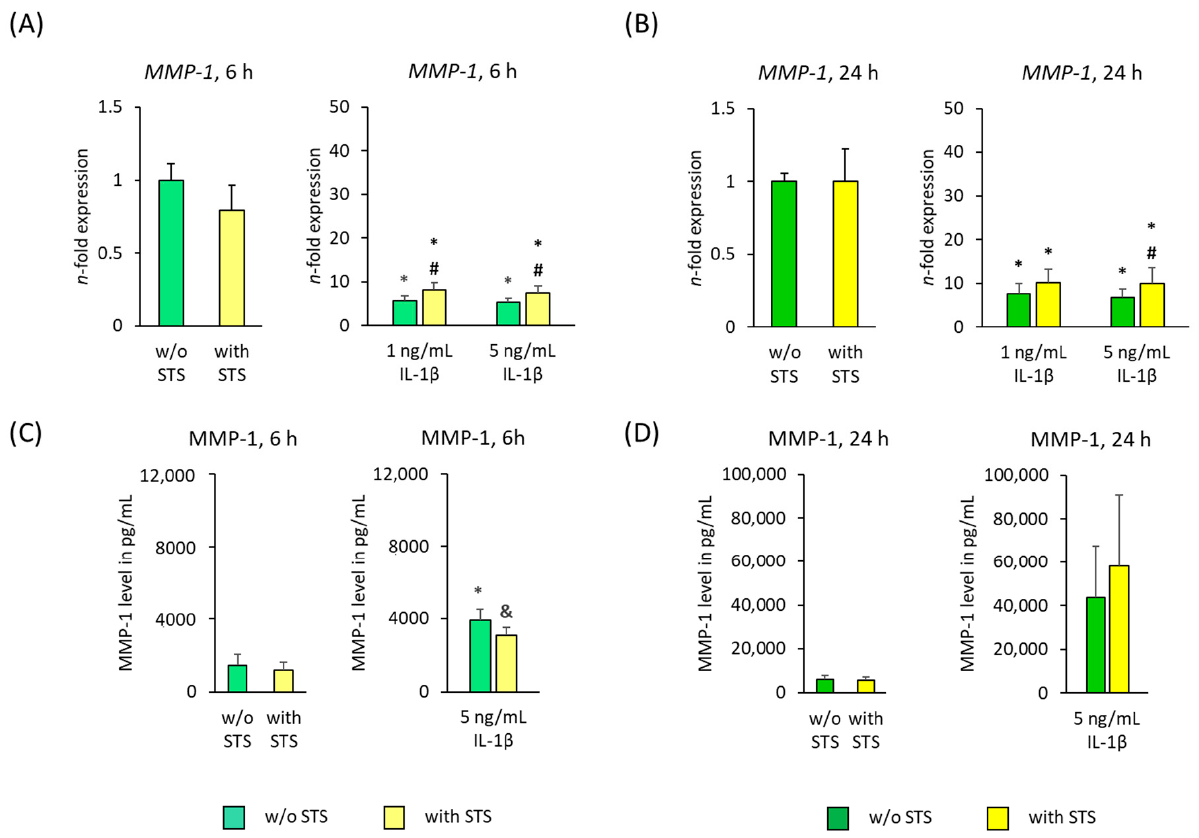
Figure 3. Effect of static orthodontic tensile forces on the IL-1 β -induced gene and protein expression of MMP-1 in hPDL-MScs in the presence of 2% FBS. STS with 6% equibiaxial elongation was applied to untreated or IL-1 β -treated hPDL-MSCs in the presence of 2% FBS. 6 ( A ) and 24 ( B ) hours after stimulation with and without STS, qPCR was performed showing the n -fold expression levels of MMP-1 compared to the appropriate controls ( n -fold expression = 1). GAPDH served as an endogenous control. Corresponding MMP-1 protein levels were determined in pg/mL by ELISA in conditioned media, which were harvested 6 ( C ) and 24 ( D ) hours after stimulation with or without STS. All data are presented as mean ± S.E.M. * p -value ≤ 0.05 significantly higher compared to the appropriate control; # p -value ≤ 0.05 significantly higher compared to the appropriate IL-1 β stimulated cells without STS; & p -value ≤ 0.05 significantly lower compared to the appropriate Il-1 β stimulated cells without STS.